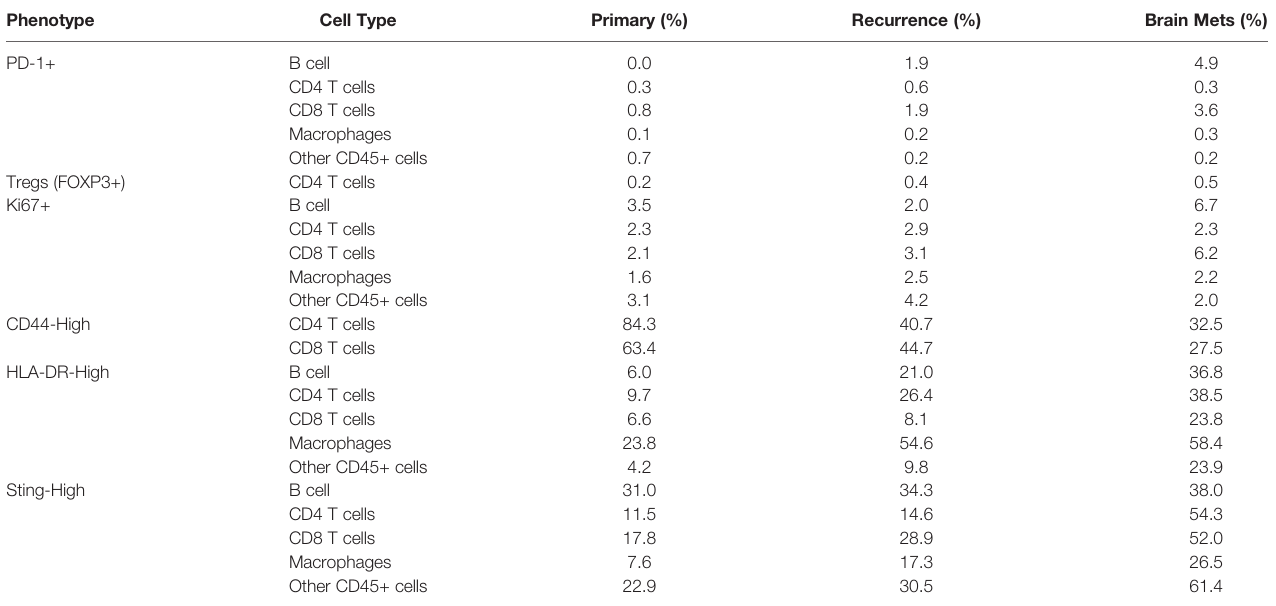
TABLE 1 | Immune cell phenotypes.